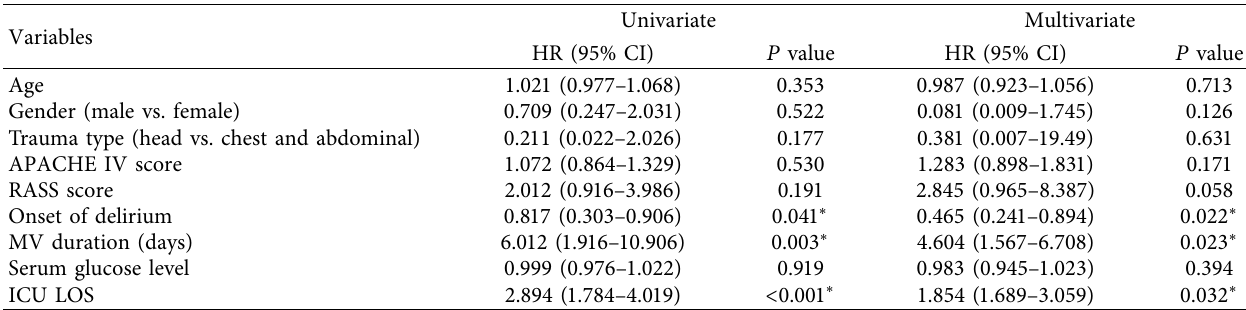
Table 3: Proportional hazard Cox regression analysis to determine the independent factors associated with VAP in patients with delirium.